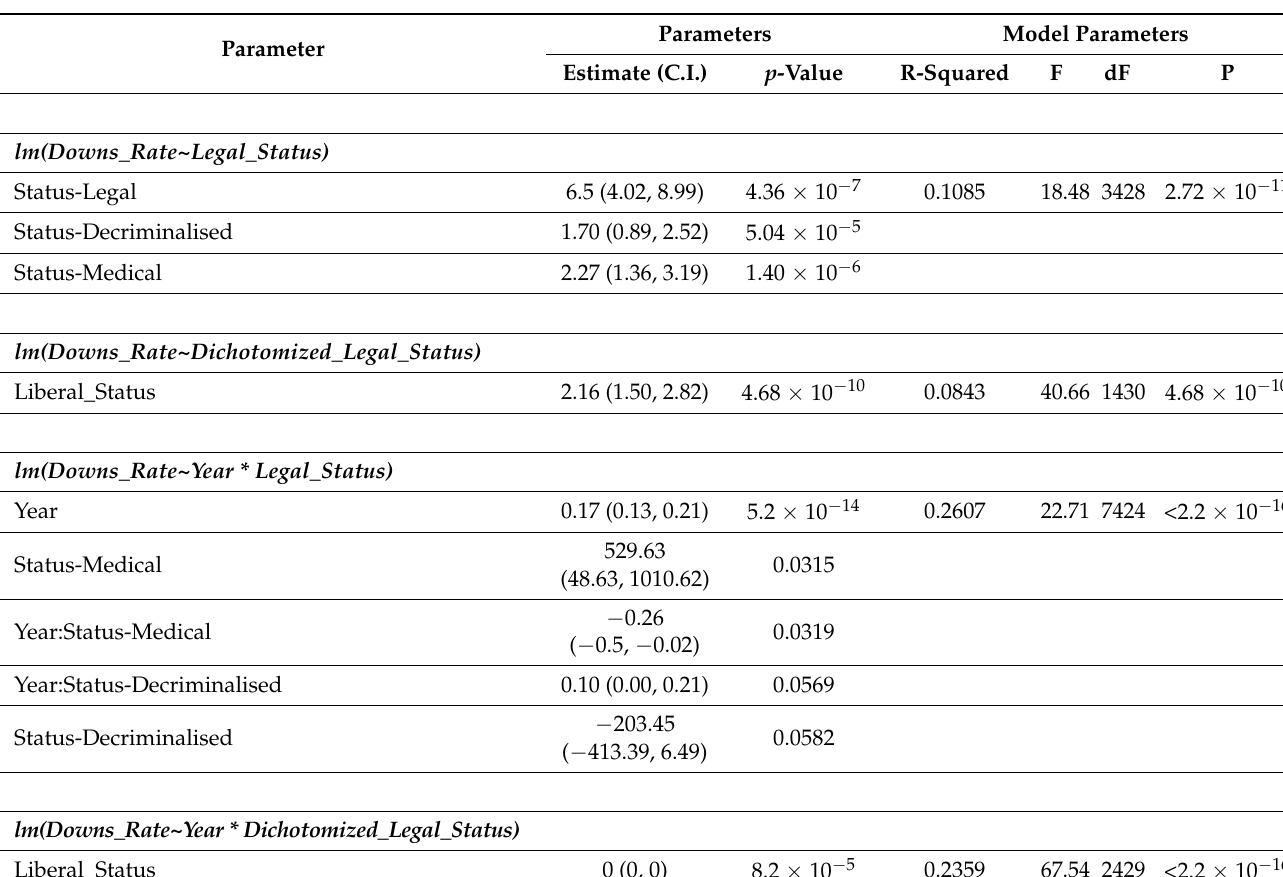
Table 2. Legal Status—Bivariate Linear